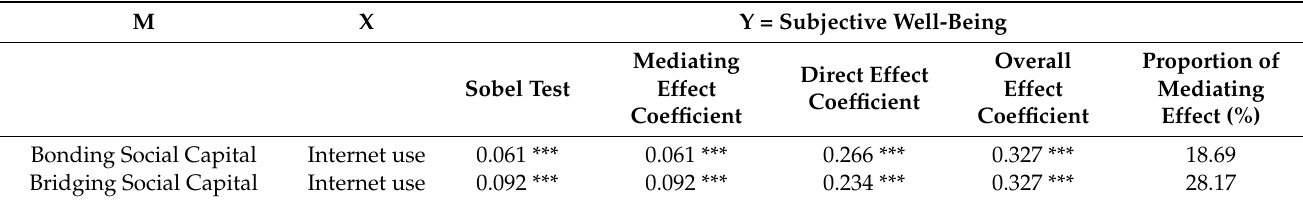
Table 4. Analysis of the mediating effect of social capital.